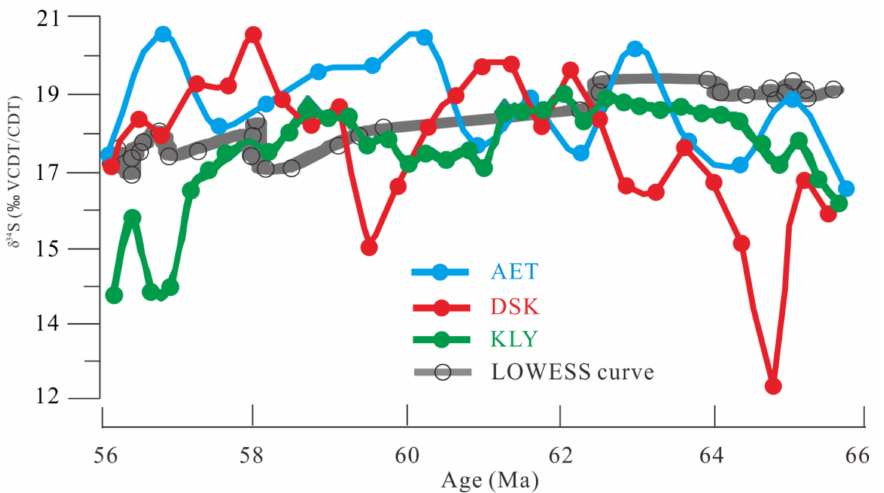
Figure 5. Sulfur isotopic curves of marine gypsum and barite. The cinereous LOWESS curve from the global marine barite data from the last c.66 Ma–Ma [45]. The blue, red, and green curves are from the data of AET, DSK, and KLY gypsum profiles of the Yarkand Basin during the Paleocene,